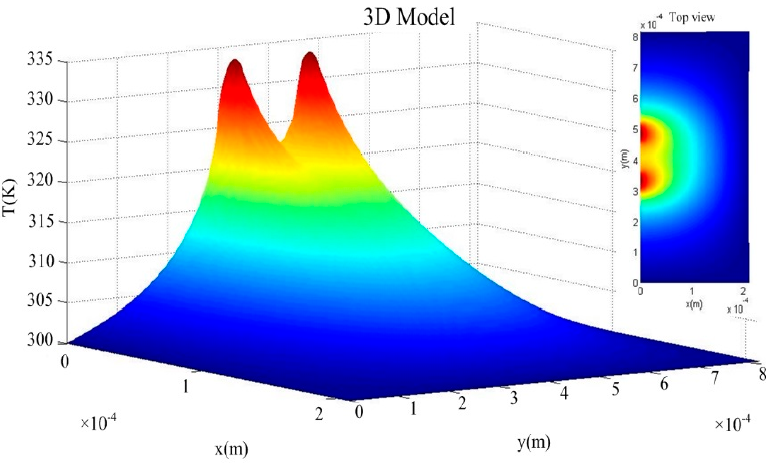
Figure 3. Calculated temperature distribution of the power sensor from the 3D model by the Matlab software. Table 1. Parameters of the model.